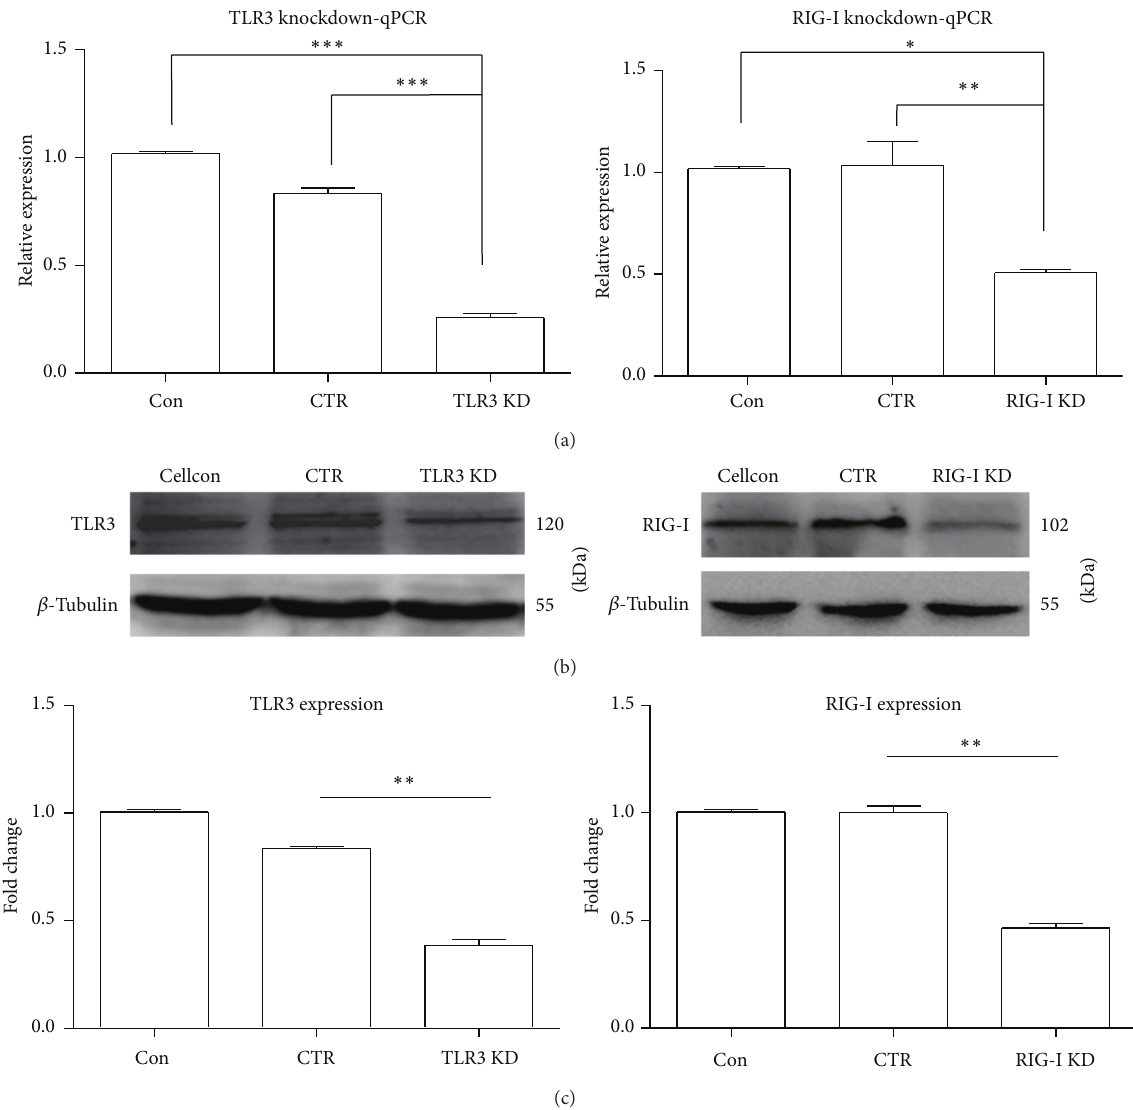
Figure 4: Knockdown of TLR3 and RIG-I in BV-2 cells with shRNA transfection. BV-2 cells were transfected with shRNA specific for TLR3 (TLR3 KD), RIG-I (RIG-I KD), or control (CTR). (a) At 48 h after transfection, total cellular RNA was isolated, and the levels of TLR3 and RIG-I mRNAs were determined with qRT-PCR. (b) Western blotting was performed to detect TLR3 and RIG-I. (c) Proteins were quantified with immunoblot scanning and normalized to the amount of 𝛽 -tubulin. Error bars represent the standard deviation of results from three independent assays ( ∗ 𝑃 < 0.05 ; ∗∗ 𝑃 < 0.01 ; ∗∗∗ 𝑃 < 0.001 ).